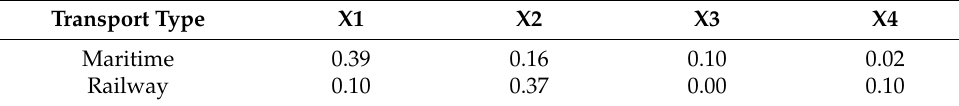
Table 2. The normalized matrix R.